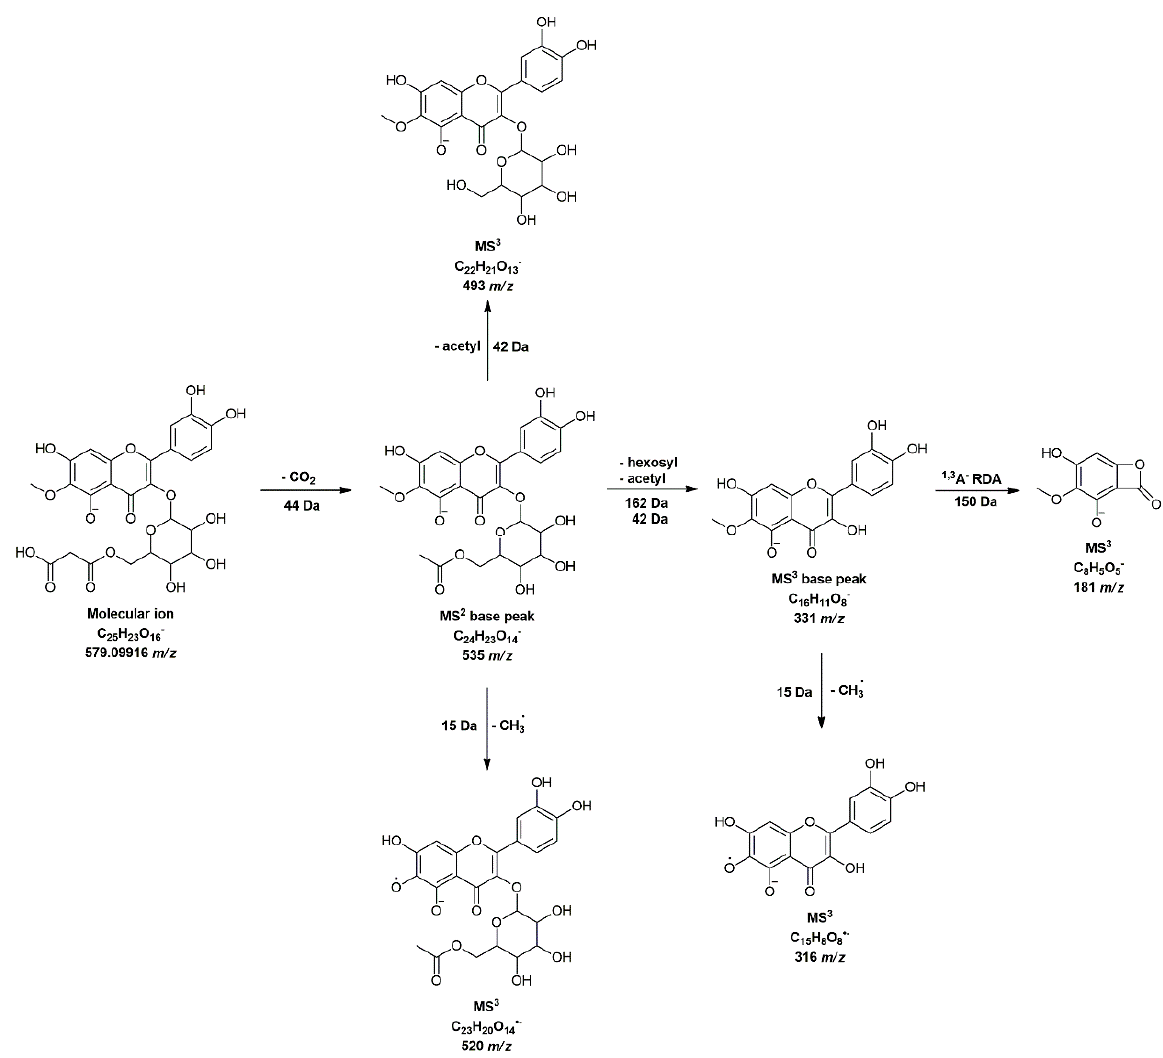
Figure A1. Fragmentation pathway of isorhamnetin 3- O -(2 ″ -hexosyl-6 ″ -malonyl-hexoside (com- pound 16).